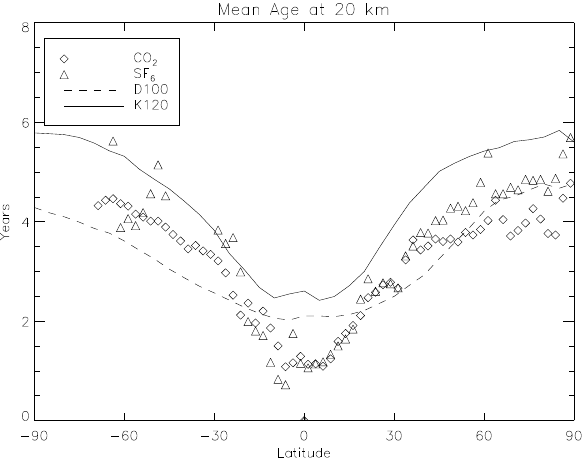
Fig. 5. Zonal mean water vapor mixing ratio at the end of the particle integrations – 30 December 2009 . Top D100 (Diabatic, 100% super-saturation) experiment, bottom MLS V3 observations (see Table 1). Zonal mean temperatures are shown as black con- tours. Temperature data are from